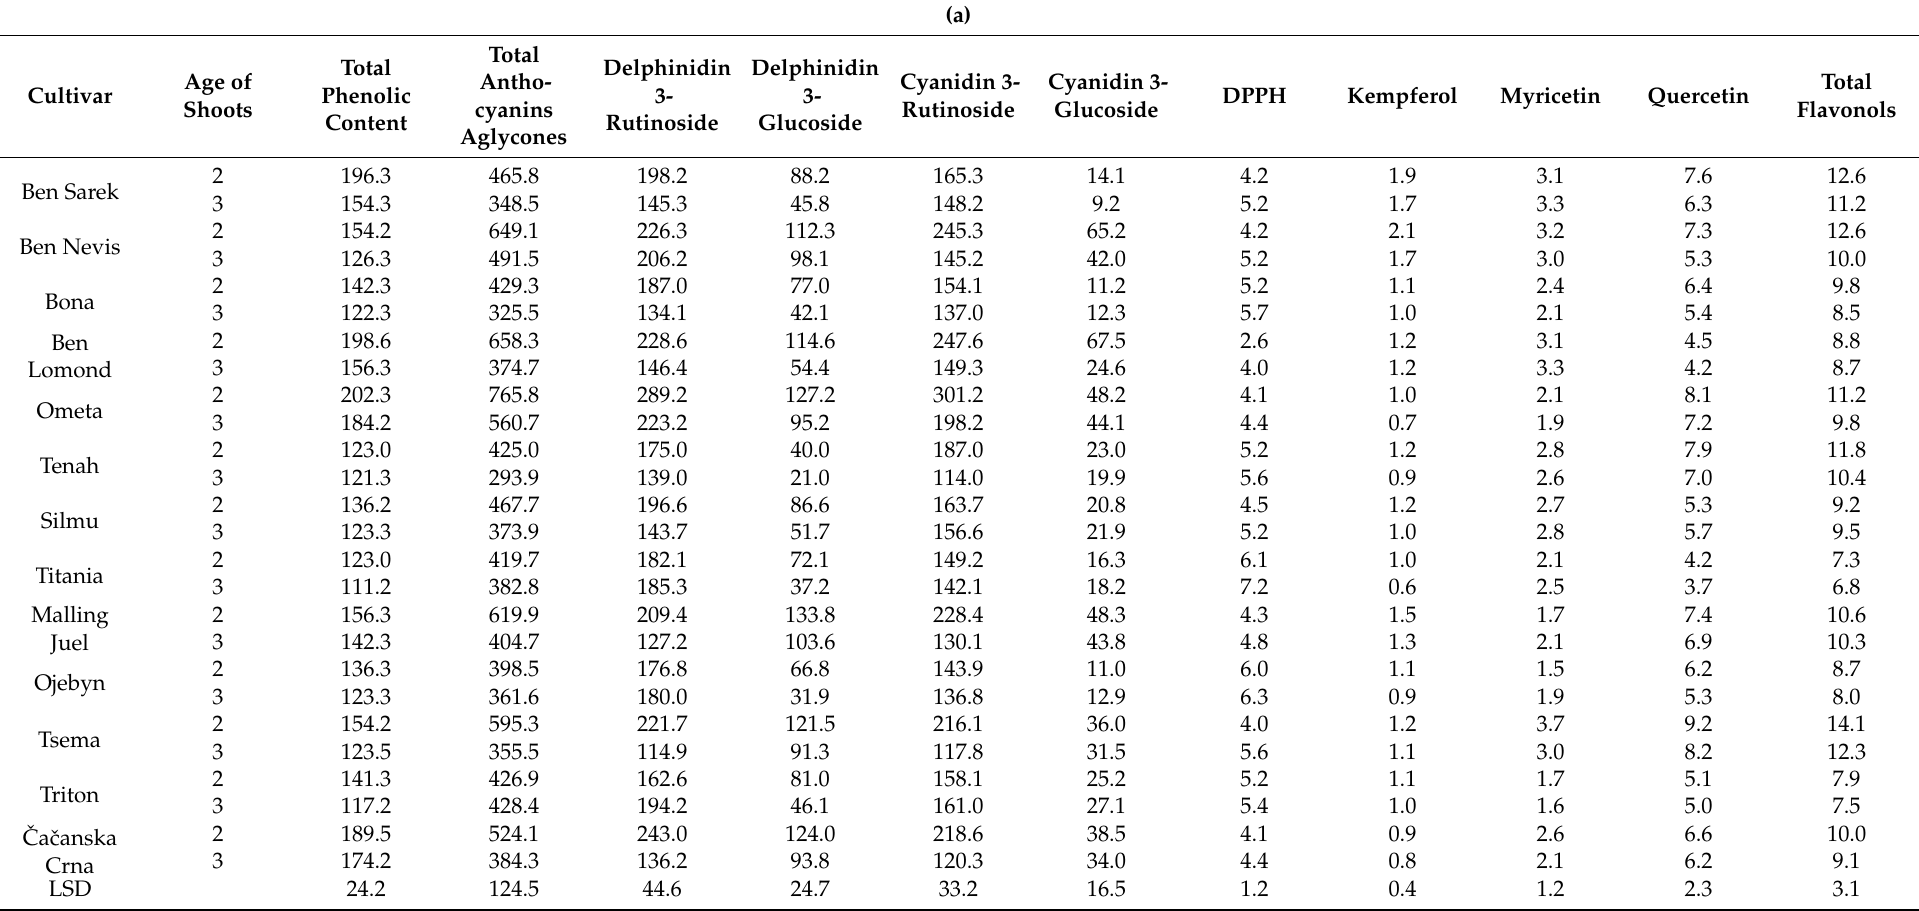
Table 4. ( a ) Content of total phenols (mg/100 g f.w.), anthocyanins (mg/kg f.w.) and flavanols (mg/kg f.w.), aglycones, and DPPH (mg/mL) in 2018 year. ( b )